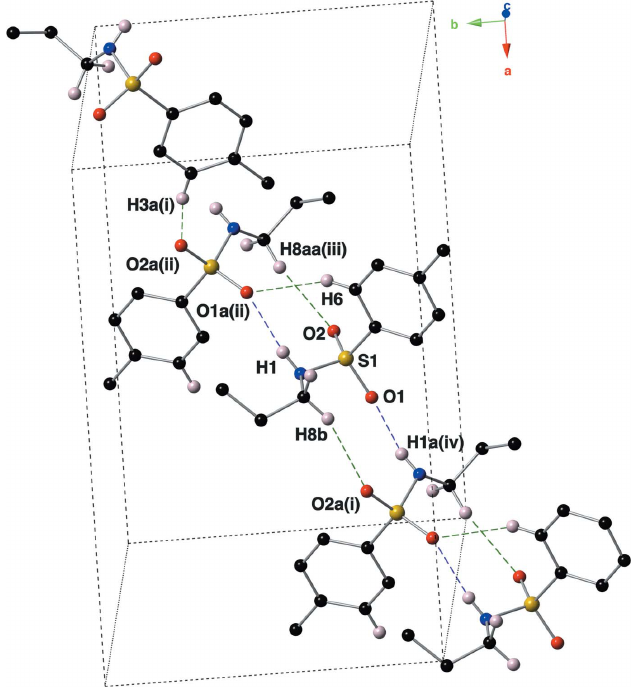
Figure 4 Figure 5 A diagram showing the specific hydrogen-bonding interactions (N— H (cid:2)(cid:2)(cid:2) O: purple dashed lines, C—H (cid:2)(cid:2)(cid:2) O: green dashed lines) present in the A packing diagram of the title compound viewed down the b axis. title compound, using a ball-and-stick model with standard CPK colors. Intermolecular hydrogen bonds are shown with dashed lines (N—H (cid:2)(cid:2)(cid:2) O: Hydrogen atoms bonded to parent atoms that are not involved in a non- purple, C—H (cid:2)(cid:2)(cid:2) O: green). This figure was drawn using a ball and stick covalent interaction have been omitted for clarity. [Symmetry codes: (i) model with standard CPK colors. Hydrogen atoms bonded to parent x + 1 atoms that are not involved in a non-covalent interaction have been , (cid:5) y + 1 , z + 1 ; (ii) x , (cid:5) y + 1, z + 1 ; (iii) x , (cid:5) y + 1, z (cid:5) 1 ; (iv) x (cid:5) 1 , (cid:5) y + 1 , 2 2 2 2 2 2 2 z (cid:5) 1 omitted for ]. 2